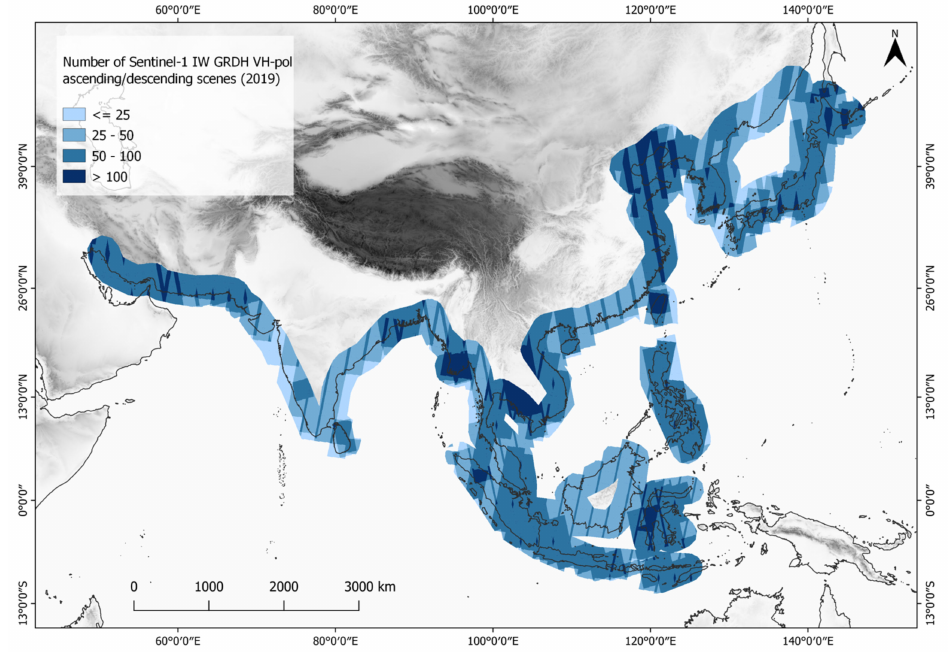
Figure 4. Coverage frequency of VH-polarized Sentinel-1 scenes (1 January 2019–31 December 2019) for the coastal zone of Asia acquired in ascending and descending